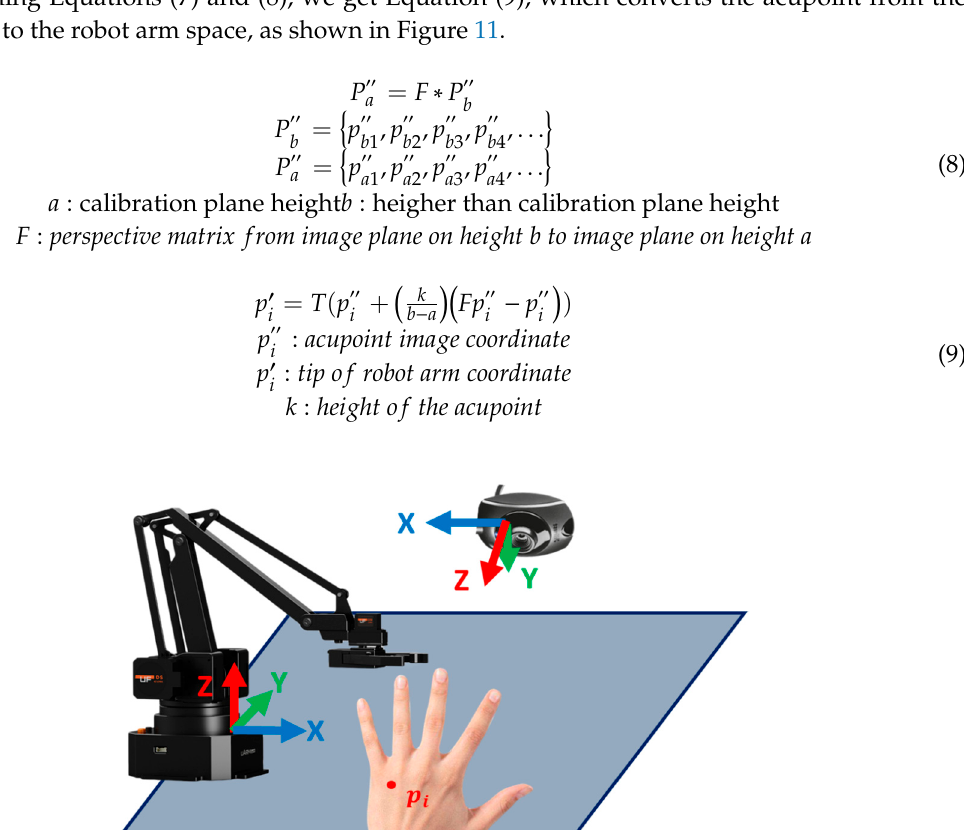
Figure 10. Diagram of the fine-tuned height.